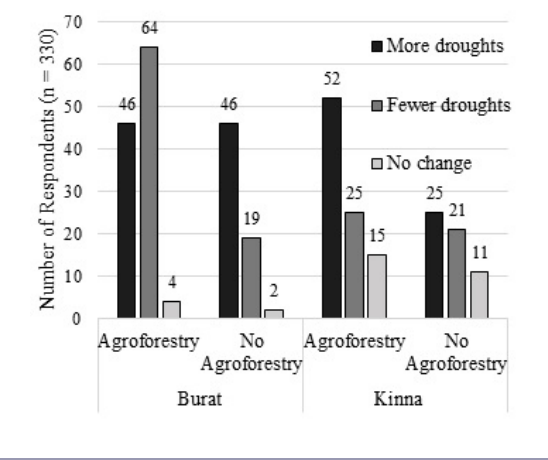
Fig. 2. Household perception of changes in the frequency of drought over the previous 10 years based on the community and whether a household practices